Question: Provide a one-line summary of what is displayed.
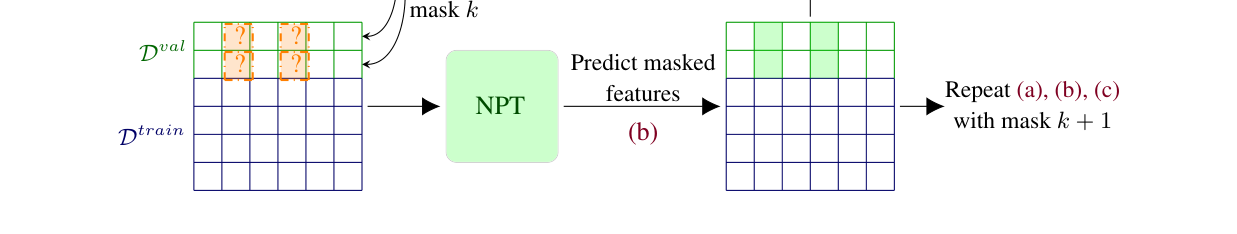
Answer: NPT-AD inference pipeline. In step (a), mask j is applied to each validation sample. We construct a matrix X composed of the masked validation samples and the whole unmasked training set. In step (b), we feed X to the Non-Parametric Transformer (NPT), which tries to reconstruct the masked features for each validation sample. On top of the learned feature-feature interactions, NPT will use the unmasked training samples to reconstruct the mask features. In step (c), we compute the reconstruction error that we later aggregate in the NPT-AD score.